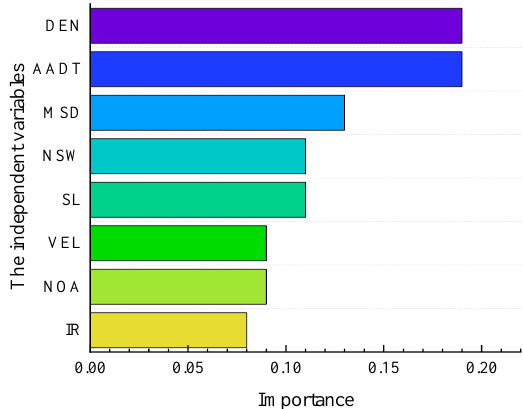
Figure 4. Order of importance of influencing factors.